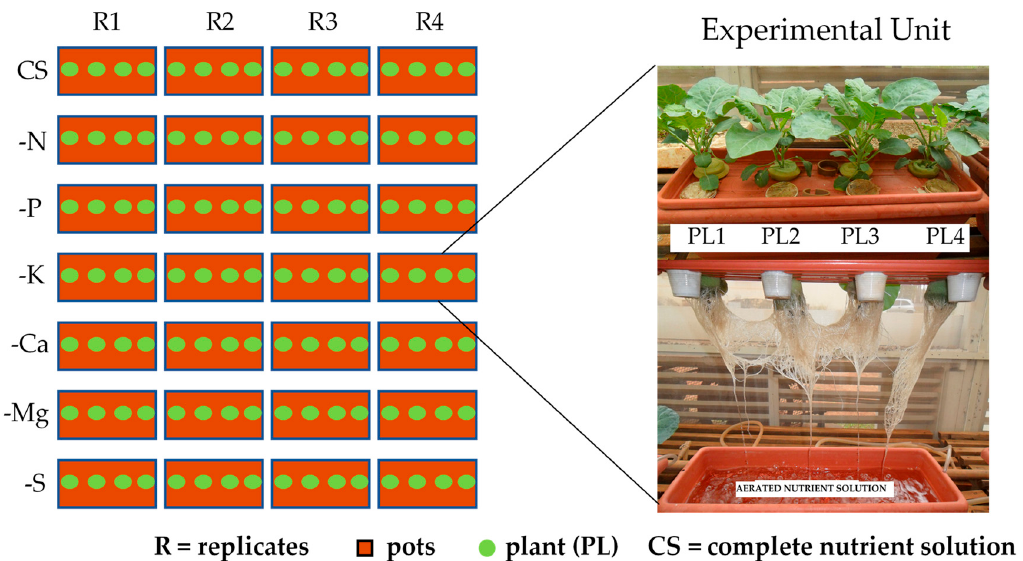
Figure 1. Representation of the experimental design and plants grown in the hydroponic system.